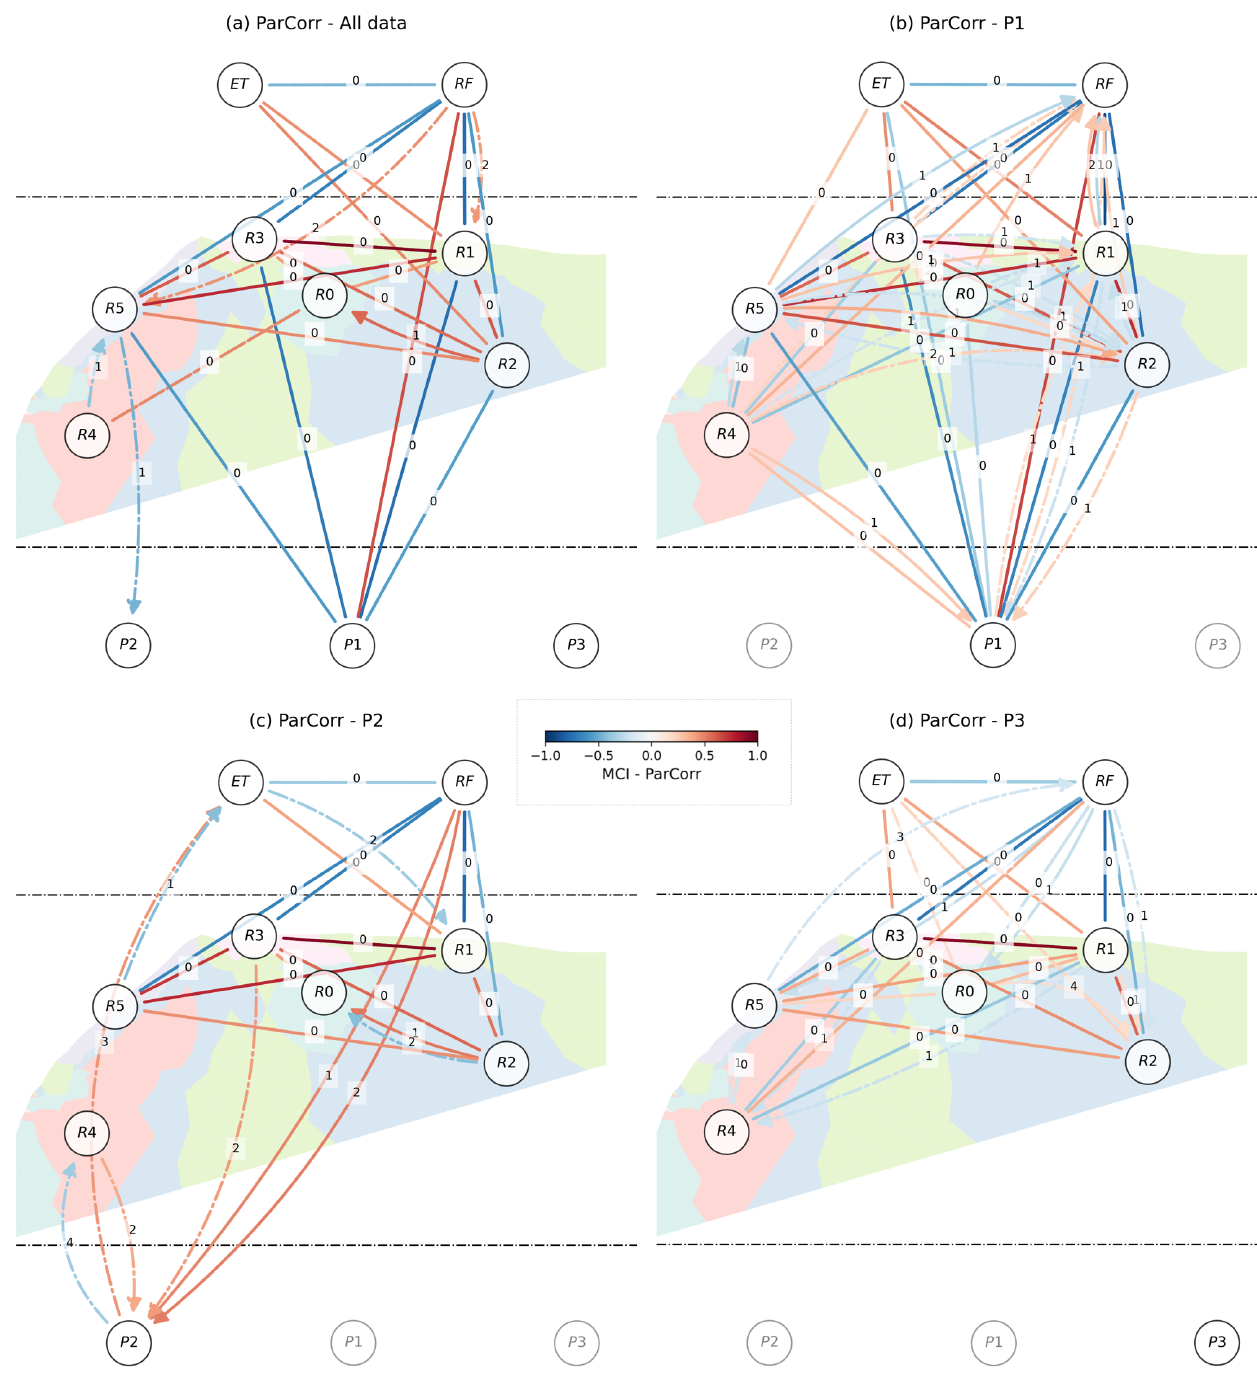
Figure 5. Graph of ParCorr cross-dependencies: considering (a) all data or one unique discharge series (b) P1, (c) P2, or (d) P3. An undirected line represents contemporaneous dependencies. Delayed dependencies are shown using directed curved arrows. All corresponding delays d are displayed in the middle of its corresponding arrow. The colors of the arrows map to the strength of dependencies. Solid and dash-dotted arrows represent, respectively, significant dependencies with p value < 0 . 001 and < 0 . 01. For each graph, the size of the overlapping time domain between the variables changes as follows: 48d (a) , 184d (b) , 62d (c) , and 218d (d)